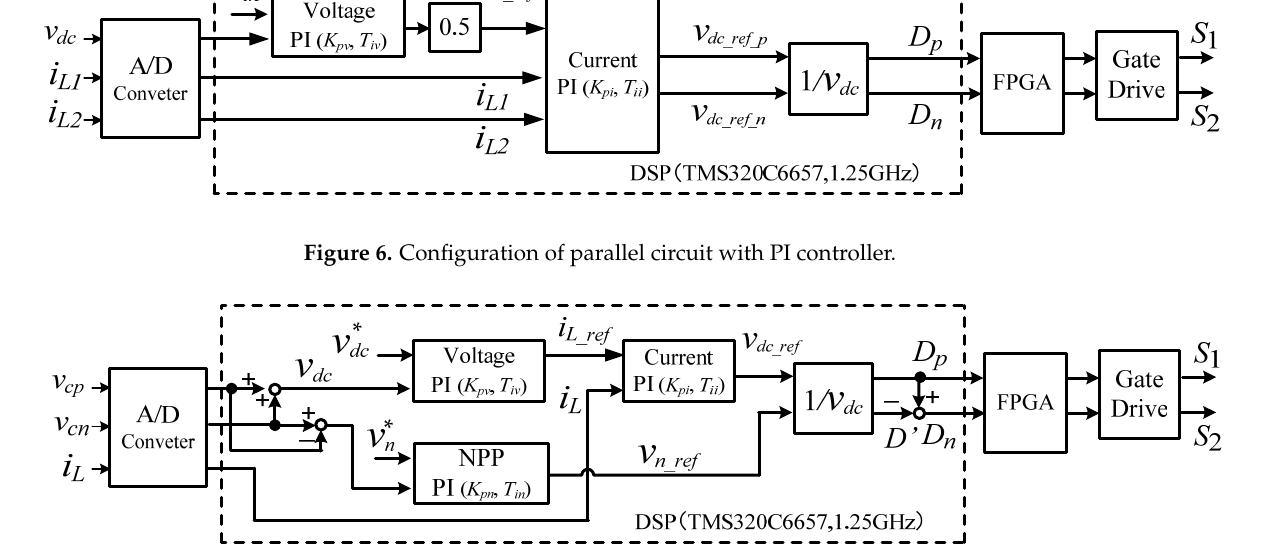
Figure 7. Configuration of series circuit with PI controller.